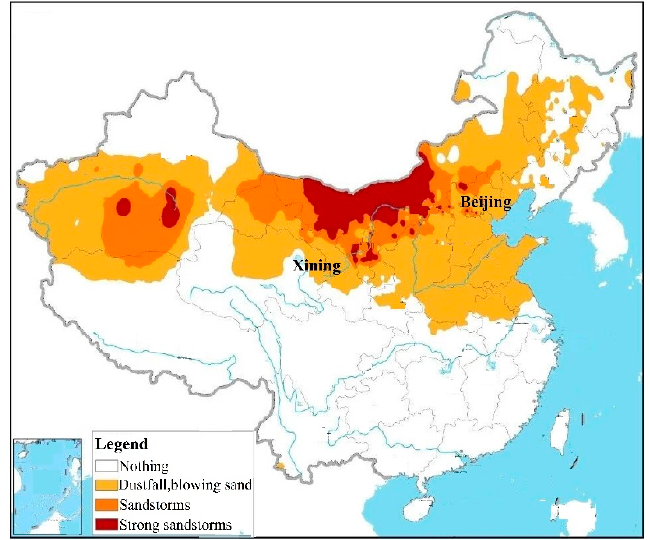
Figure 3. Distribution of dust weather in northern China from 08:00 on 14 March to 11:00 on 16 March 2021 (Provided by the Central Meteorological Observatory of China.).